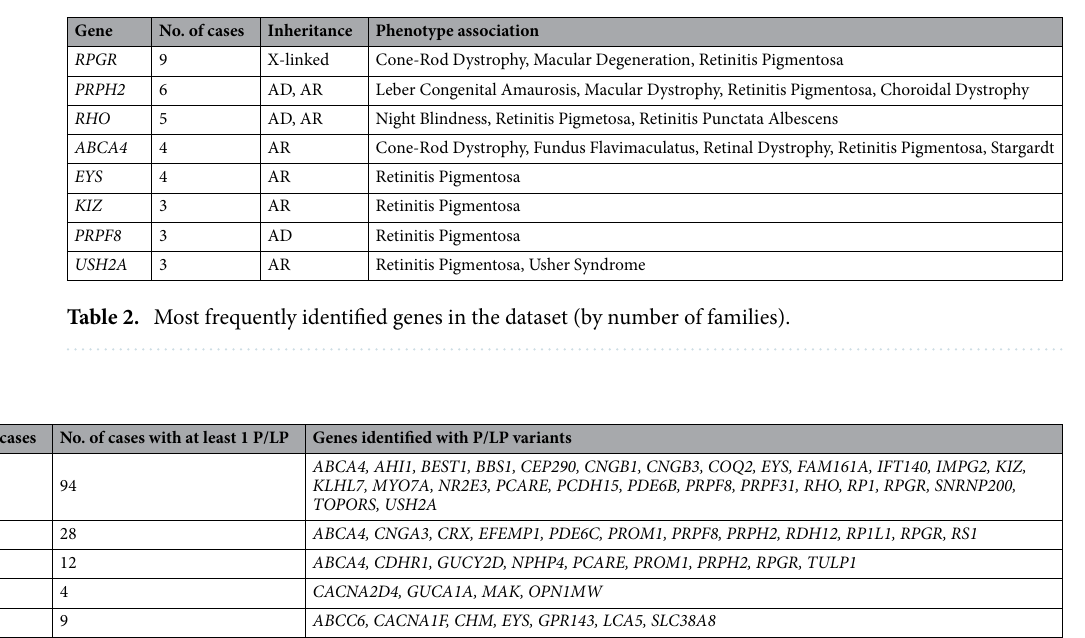
Table 3. Genes in which variants were identified by phenotype. P/LP Pathogenic/Likely